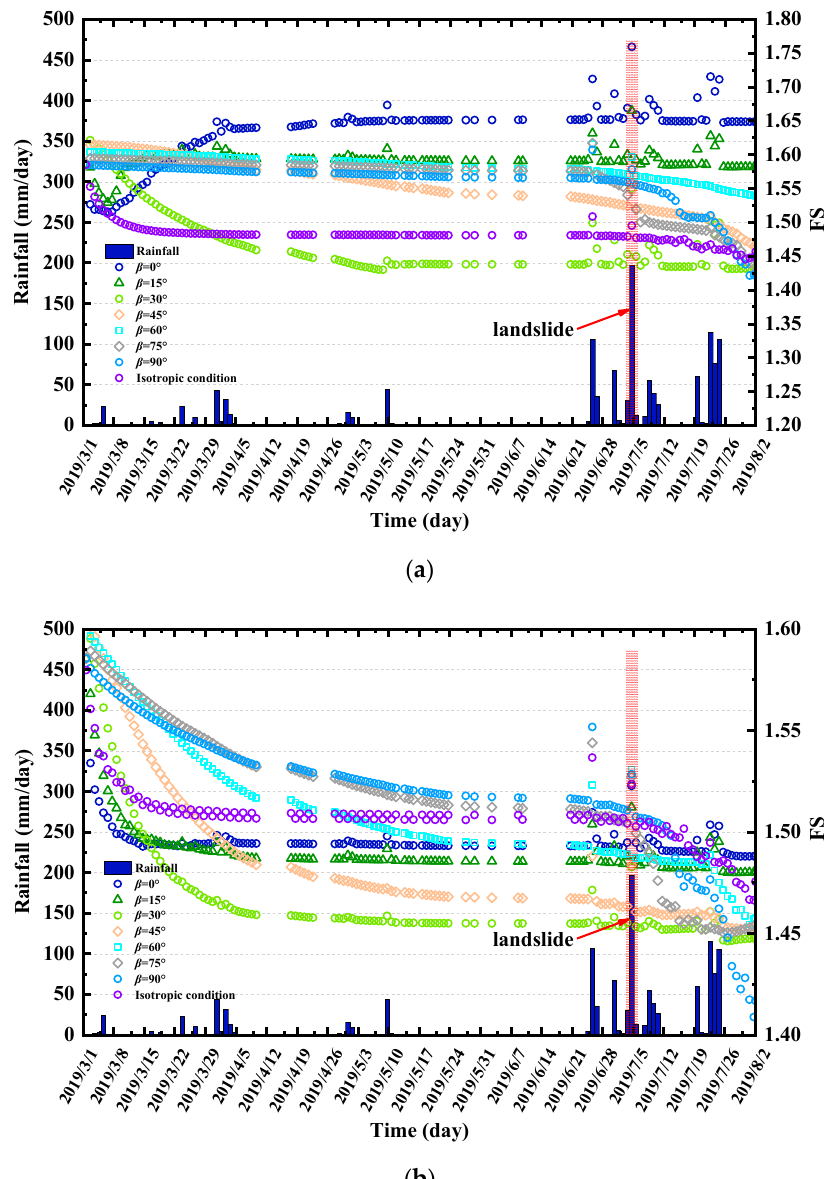
Figure 15. Variations in the factor of safety during rainfall under different β values with k r = 0.01 and k r = 0.1: ( a ) k r = 0.01; ( b ) k r = 0.1.